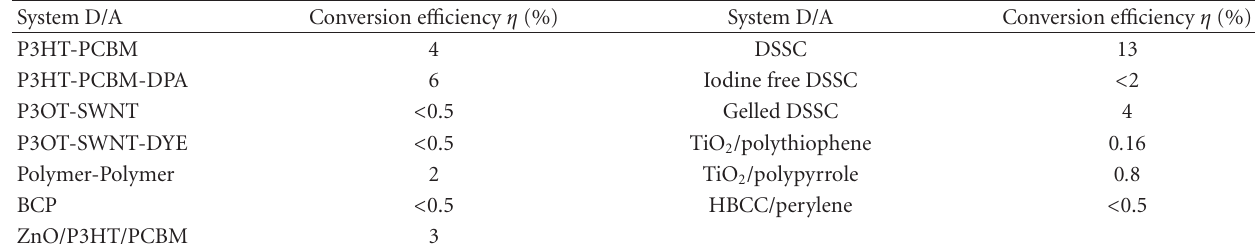
Table 1: Best performances of di ff erent